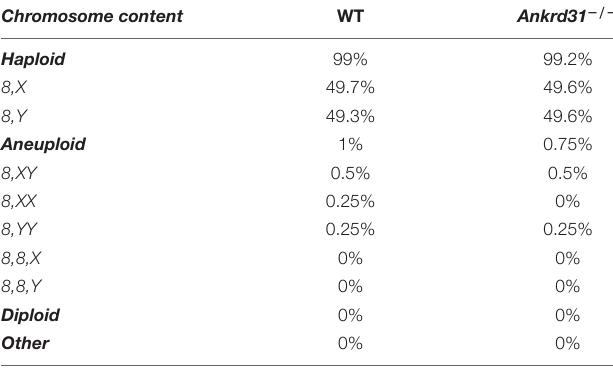
TABLE 3 | Proportion of haploid, aneuploid, and diploid spermatozoa (SPZ) in wild type (WT) and Ankrd31 − / − mice. Chromosome